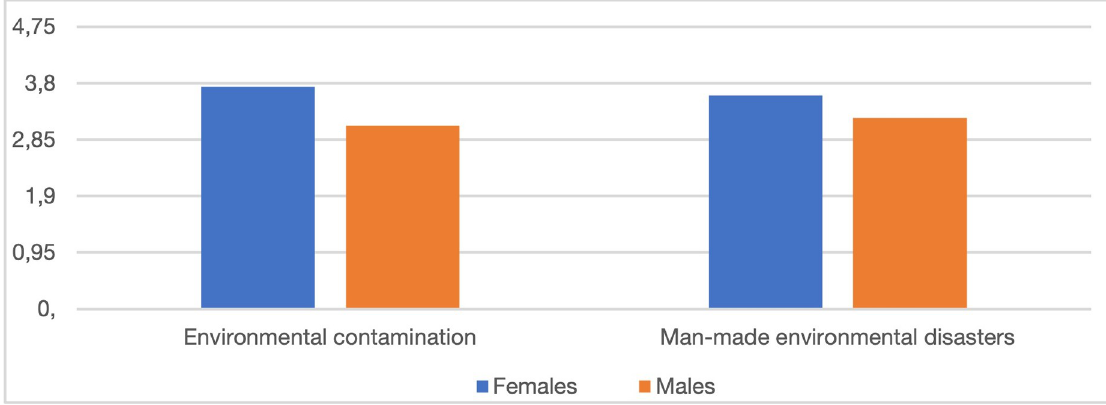
Fig 3. The probability of specific environmental risks according to women and